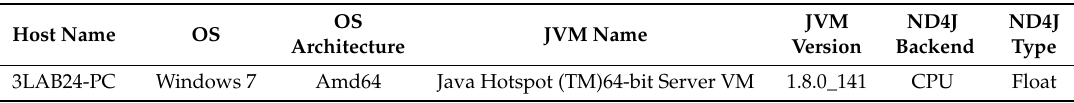
Table 11. Software information.